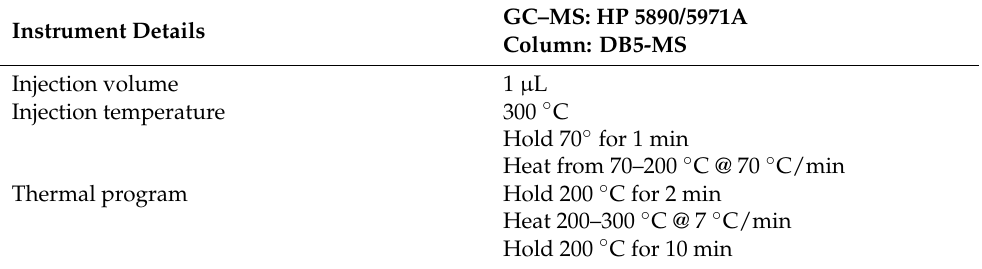
Table 4. Thermal Program